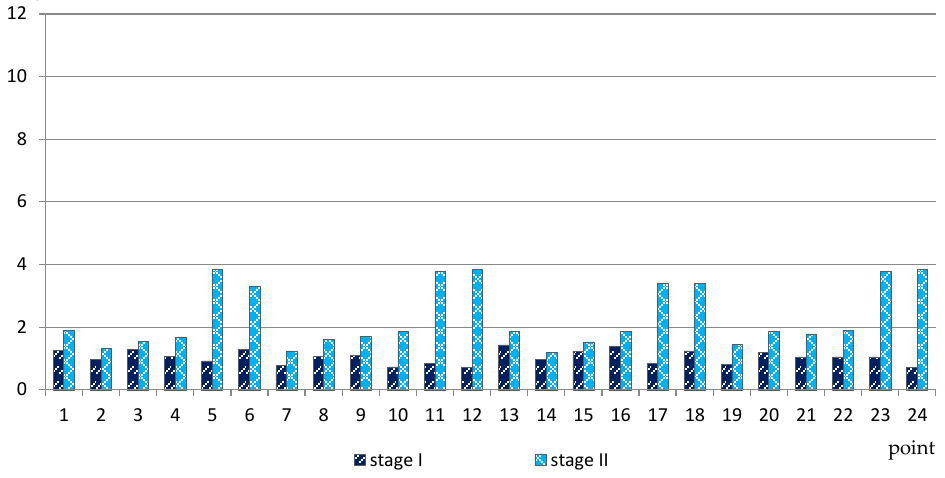
Figure 5. Corrosion current density measured on the reinforcement in C_III_a specimens.